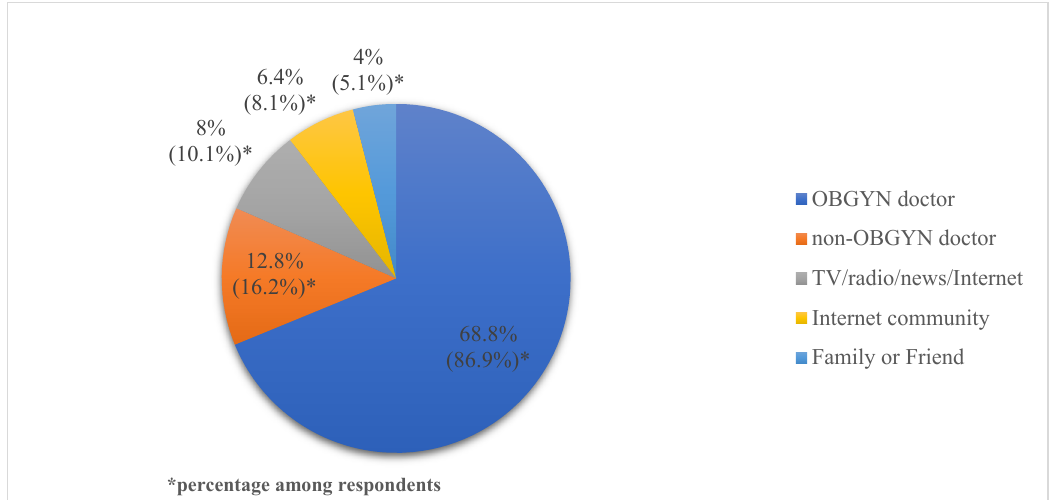
Figure 1. Concerns of pregnant or postpartum women about COVID-19 vaccination.